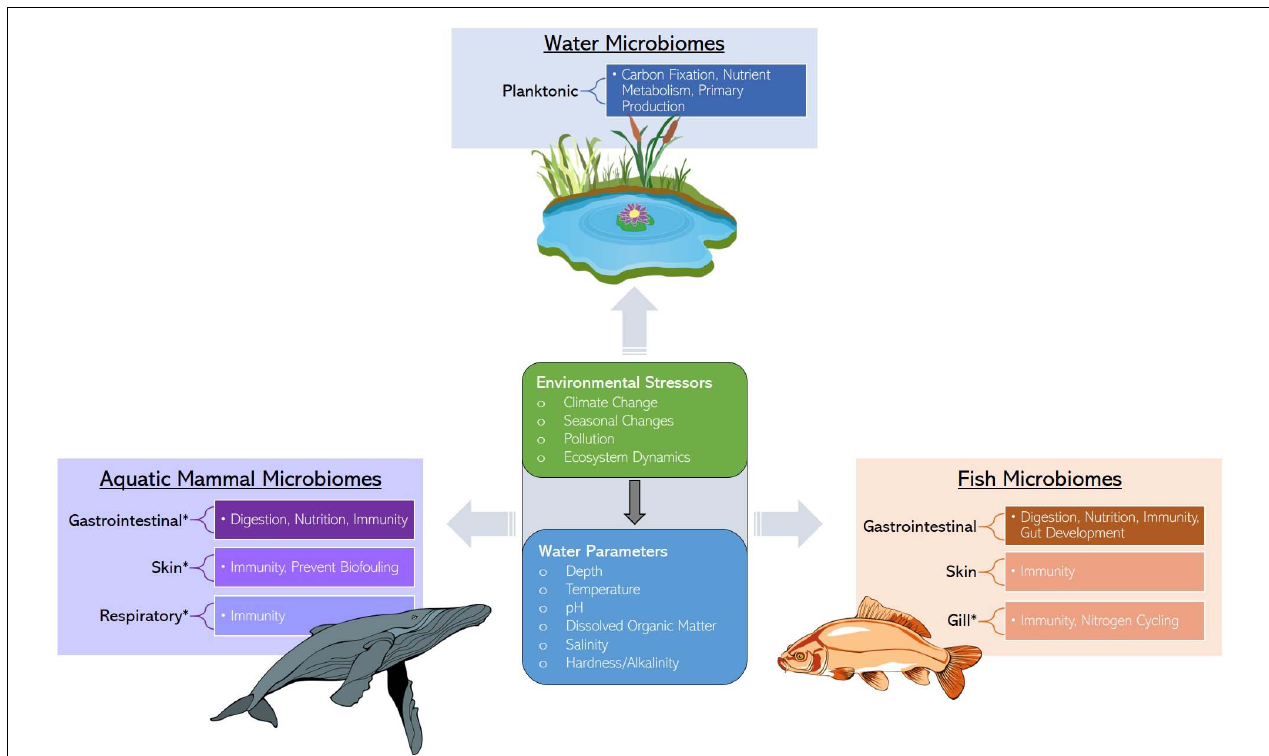
FIGURE 1 | Services provided by water, marine mammal, and fish microbiomes along with the ecological stressors and factors influencing microbiome assembly. Asterisks represent an identified research